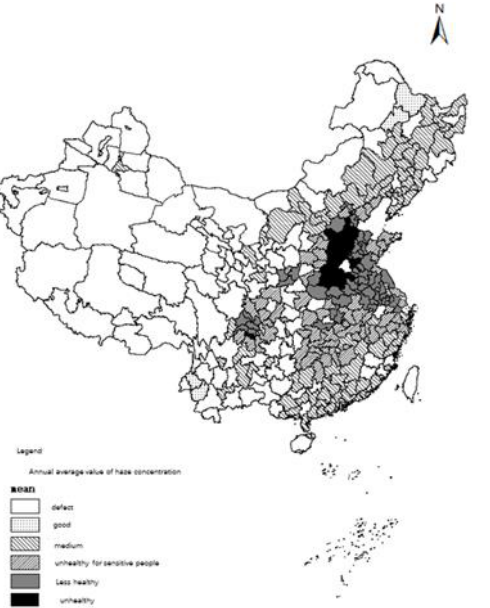
Figure 3. Annual Average Concentration of Haze from 2010 to 2012 in Chinese Prefecture-Level Cities . Source: Map of Global Annual Average Surface PM 2.5 Concentrations from SEDAC.